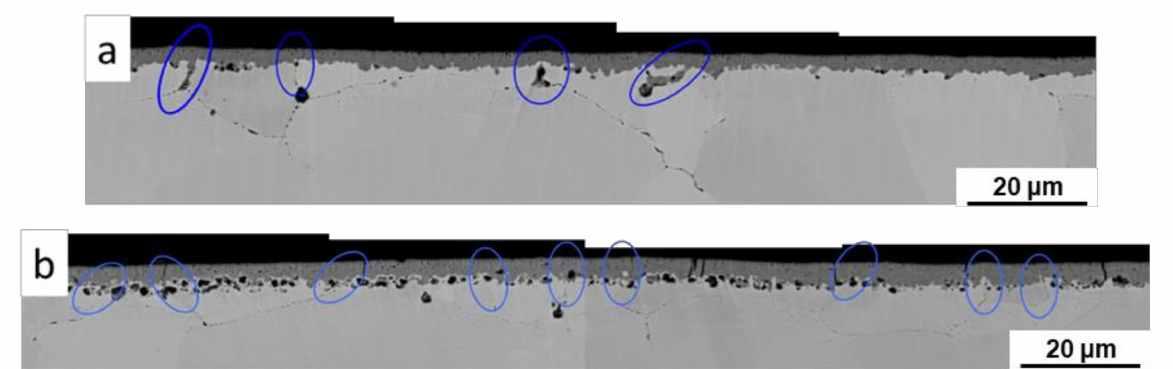
Figure 3. SEM morphologies of internal oxidation along grain boundaries of ( a ) Ar- and ( b ) H- permeated